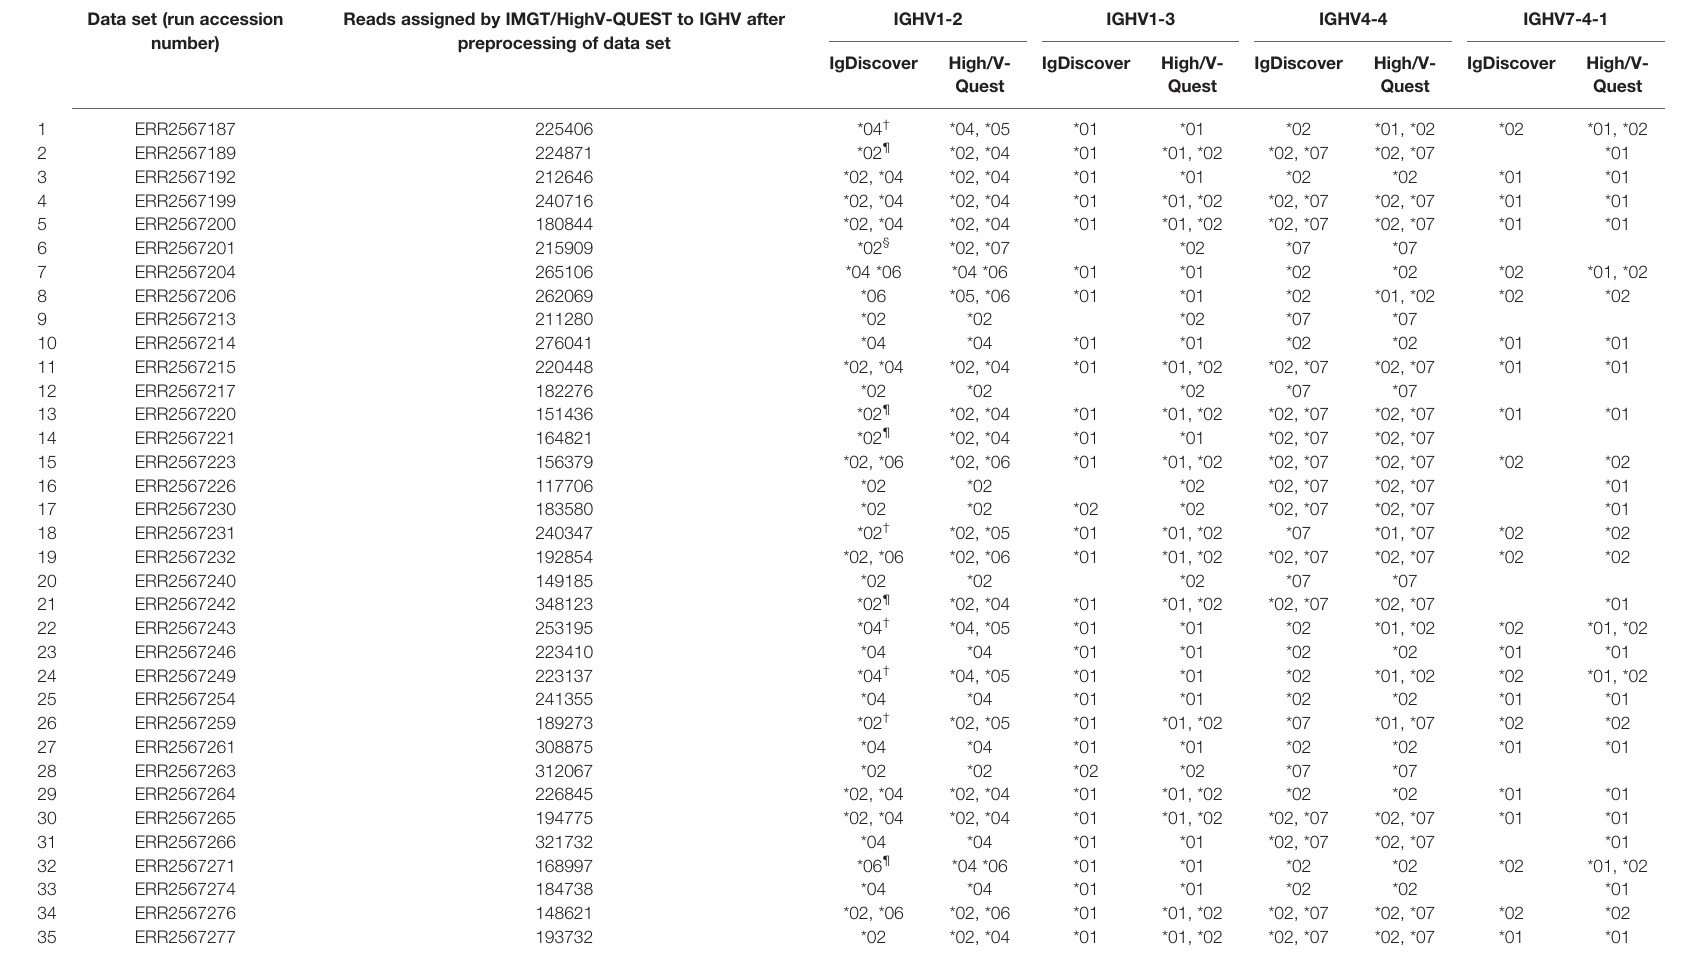
TABLE 1 | Alleles of IGHV1-2, IGHV1-3, IGHV4-4, and IGHV7-4-1 of 35 haplotypable (based on heterozygocity of IGHJ6) data sets used for the present analysis. Data set (run accession